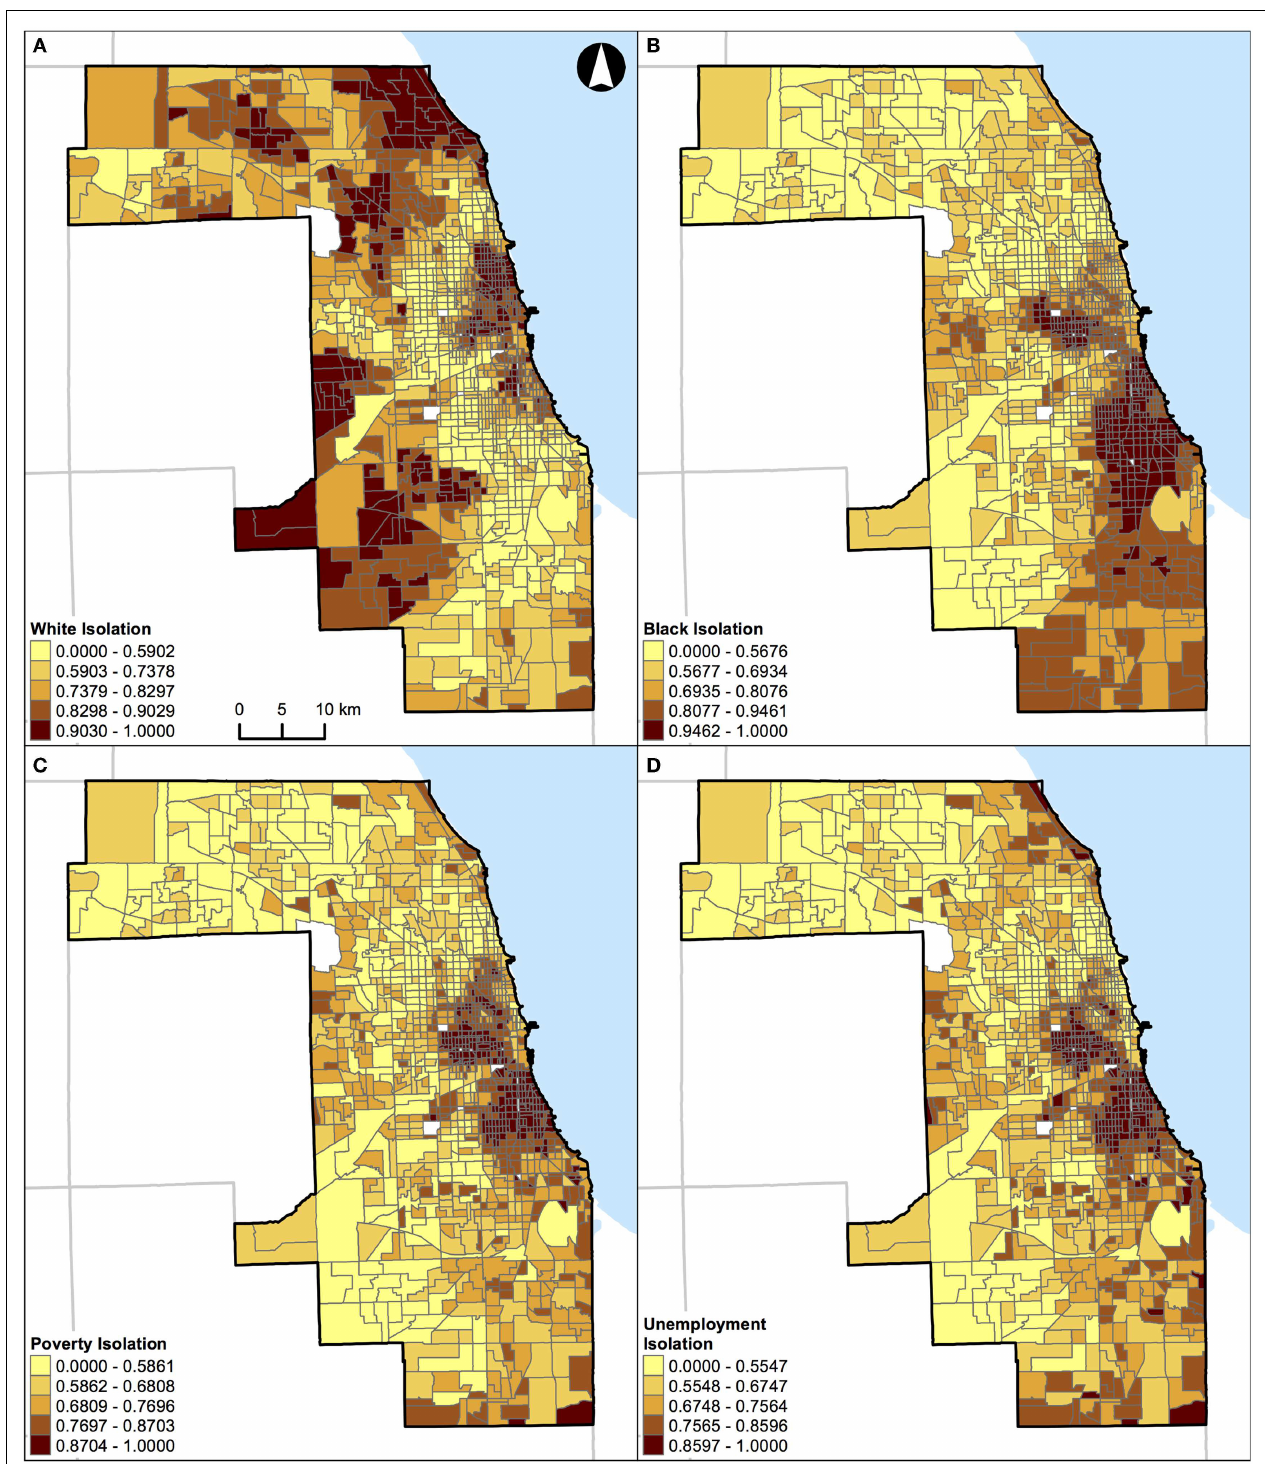
FIGURE 7 | Geographic distribution of local spatial isolation measures in Chicago, IL, USA (1,327 census tracts) . (A) White isolation, (B) black isolation, (C) poverty isolation, and (D) unemployment isolation. A quantile classification scheme was used to display the levels of local segregation.